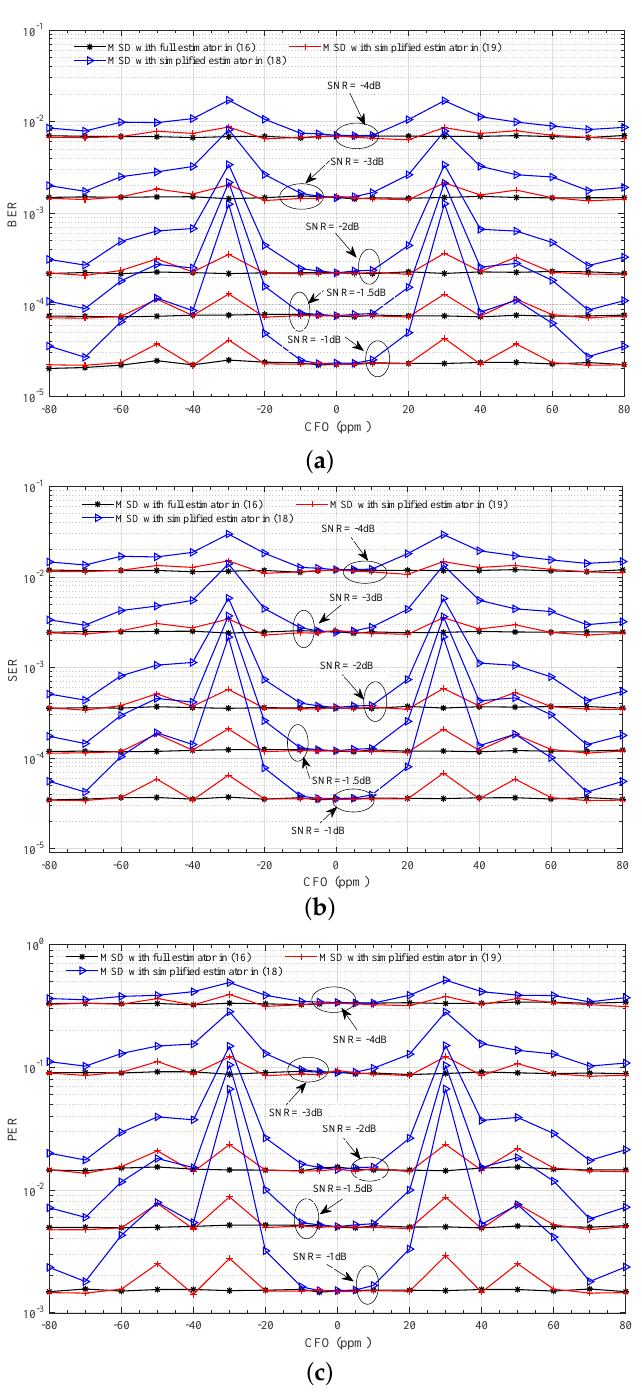
Figure 10. Detection performance comparisons of our proposed scheme under various estimators with dynamic CFOs over a pure AWGN channel. ( a ) BER performance; ( b ) SER performance; ( c ) PER